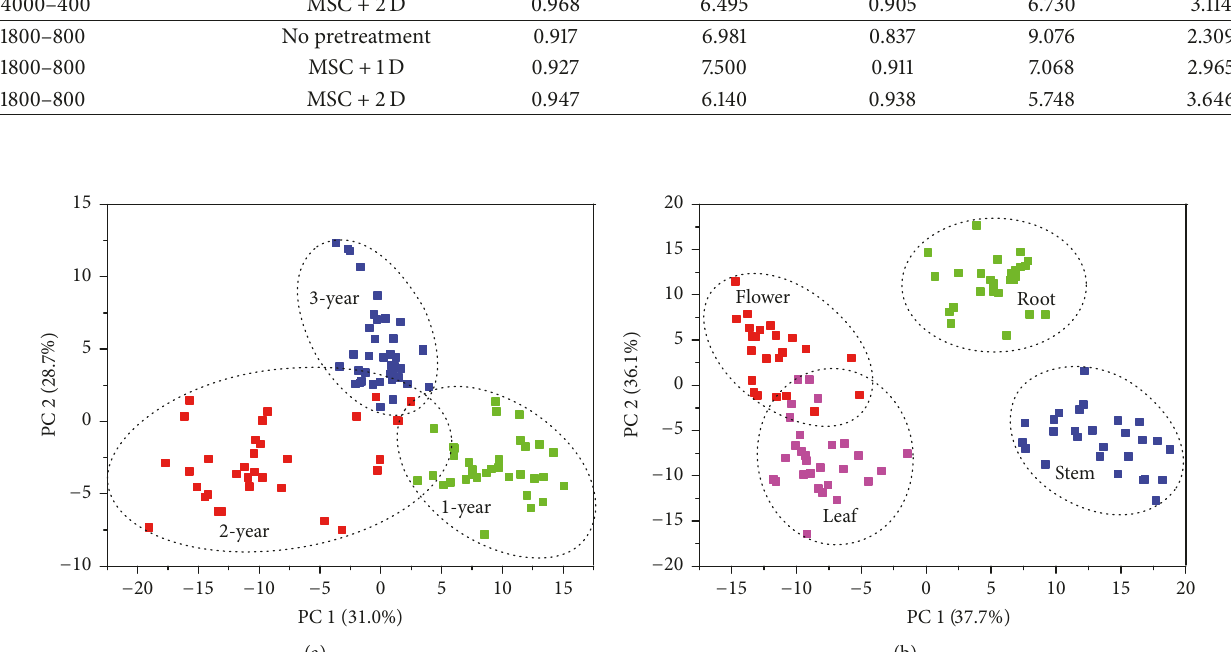
Figure 5: The score plots of G. rigescens samples based on the first two PCs. (Description: (a) shows the classification result between different cultivation ages, where the first 2 PCs can explain 59.7% information of total variance. (b) shows the classification result between different organs, where the first 2 PCs can explain 73.8% information of total variance.)